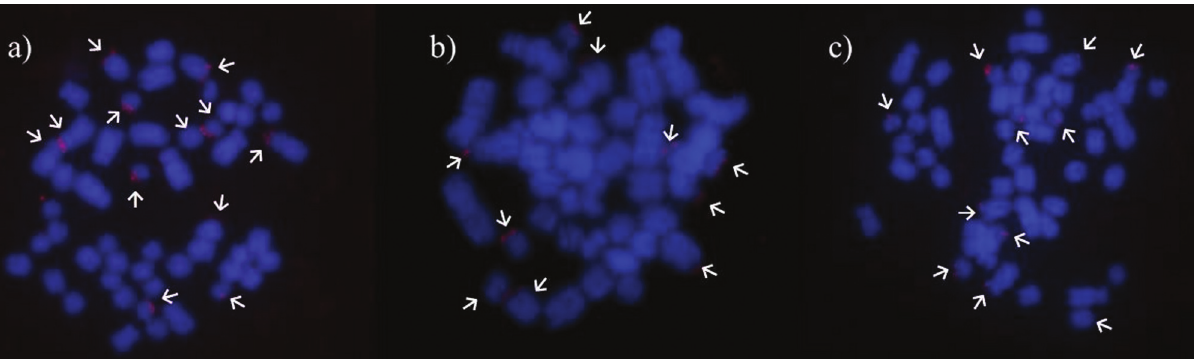
Figure 2 - FISH with the 18S rDNA probe. The probe is observed as red signals and the chromosomes were counterstained with DAPI (blue). (A) Baio type (2n = 50) with 12 signals; (B) Carabao breed (2n = 48) with ten signals and (C) crossbreed (2n = 49) with 11 signals. The arrows point to the hybrid- ization